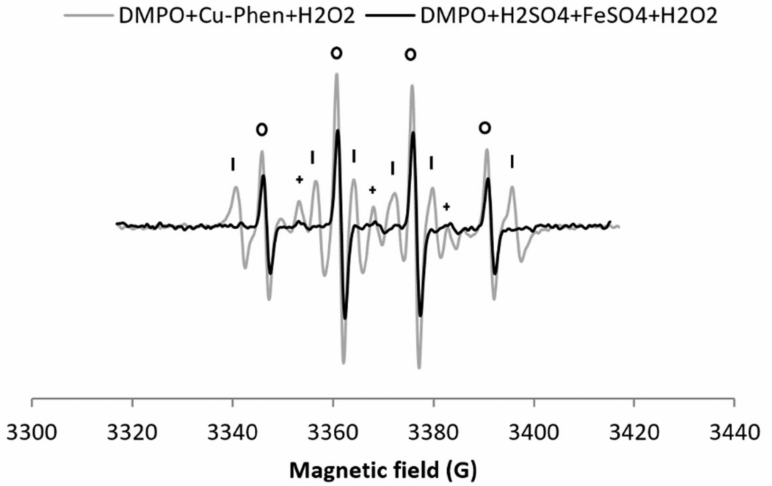
Figure 7. X-band EPR spectrum of DMPO + Cu–Phen + H 2 O 2 at near-neutral pH compared to DMPO + FeSO 4 + H 2 O 2 at pH 3 (same concentrations of H 2 O 2 and [Fe] = [Cu]). With DMPO + FeSO 4 + H 2 O 2 at pH 3 (exp 11), the simulation revealed the presence of three radical species: DMPO–OH, a N = 15.00 G, a H = 14.732 G; DMPO–R, a N = 14.675 G, a H = 21.703 G; “triplet radical”, a N = 14.793 G - Assignments: o = DMPO–OH, | = DMPO-R, + = “triplet